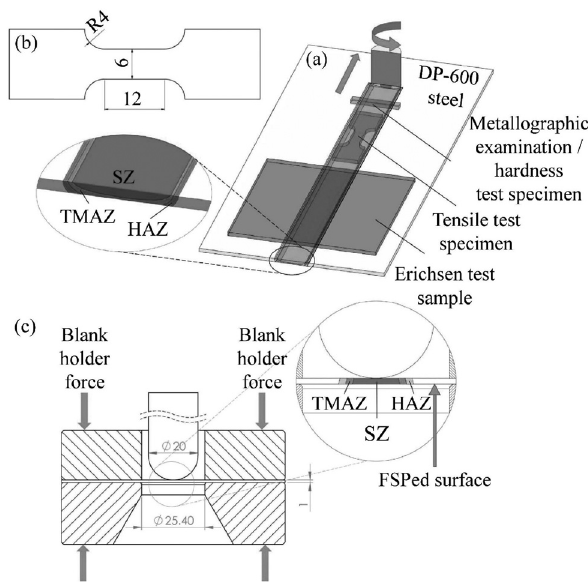
Figure 1: Schematic illustrations of ( a ) locations of the test specimens in FSPed sheet, ( b ) dimensions of tensile test specimen, and ( c ) testing positionoftheFSPedsampleinthe cupping test die ( SZ:stir zone,